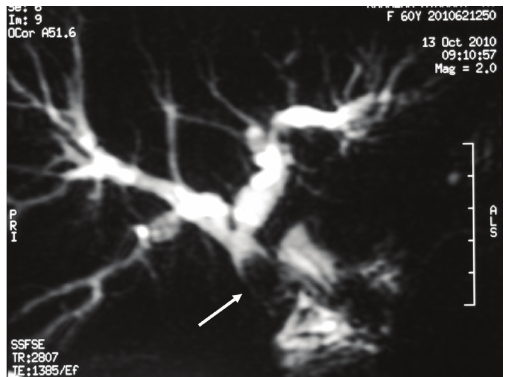
Figure 1: Magnetic resonance cholangiopancreatography revealed stricture of the hepaticojejunostomy anastomosis and mild dilatation of the biliary tree. The arrow shows the gallstone, which was localized in the common hepatic duct, just above the hepaticojejunostomy anastomosis.